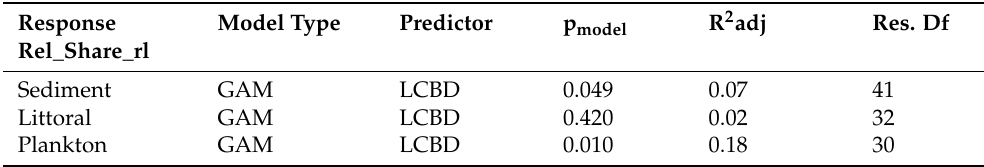
Table 4. A significant correlation between the abundance share of RL species (rel_share_rl) and the local contribution to β diversity (LCBD) was revealed by GAMs for sedimentary and planktic